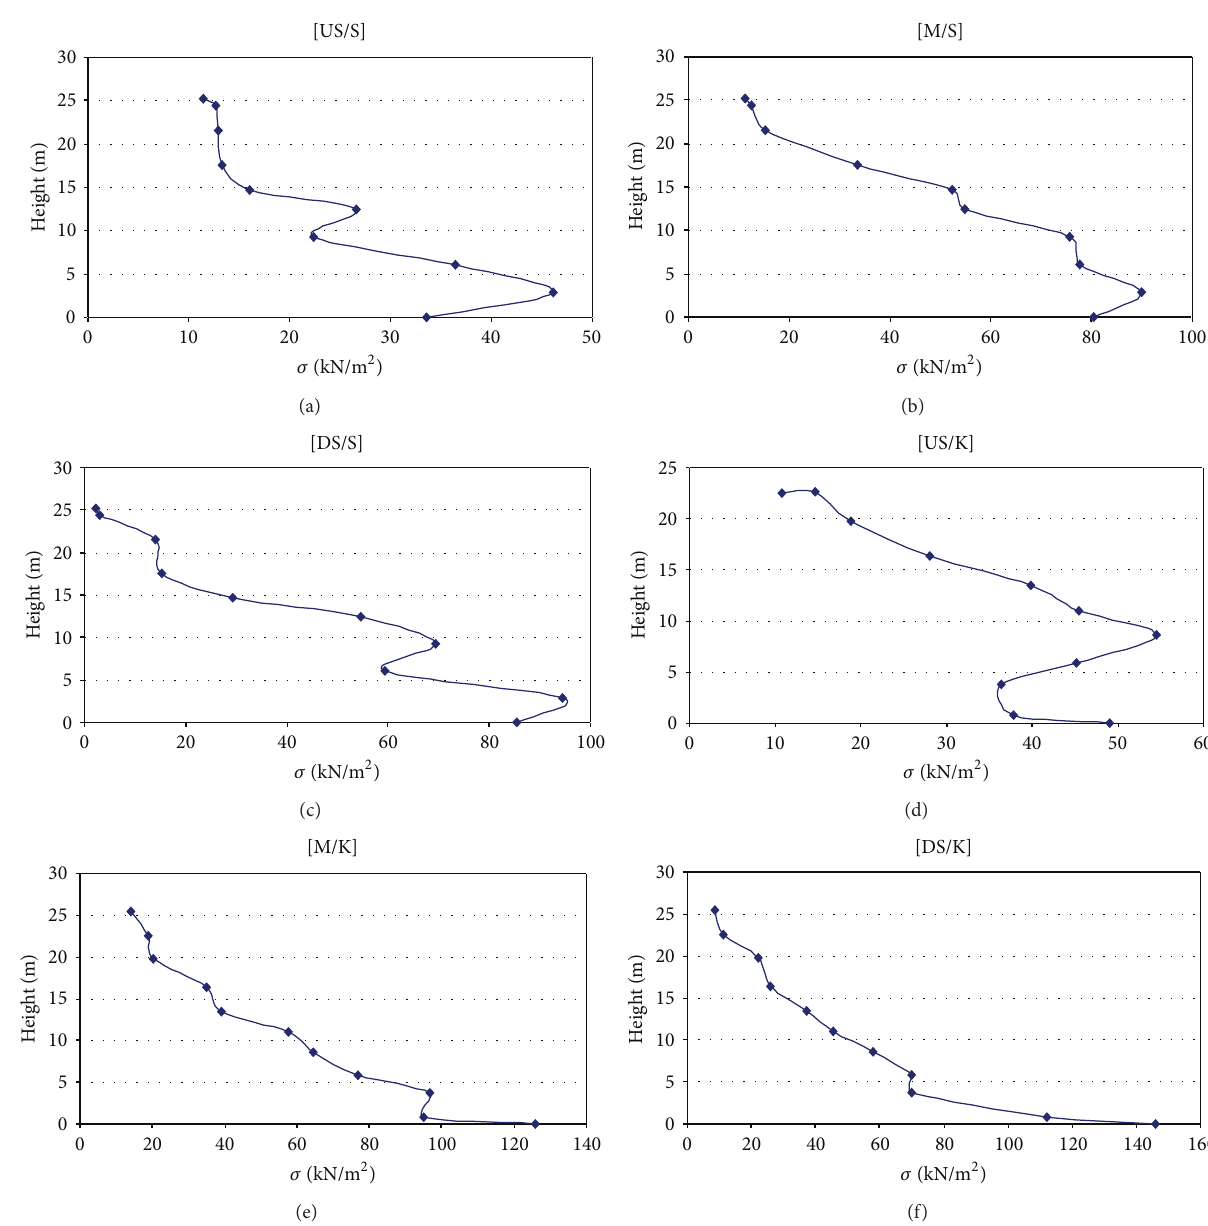
Figure 13: Approximated stress curves for various parts of Upper San Fernando (S) and Kitayama (K)